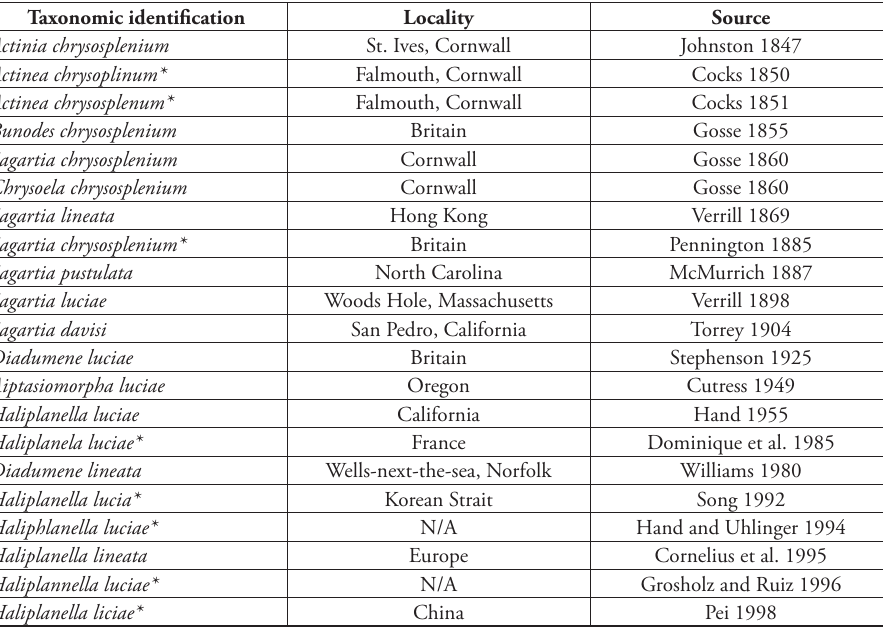
Table 1. Synonyms, misidentifications, and their localities for D. lineata (after Fautin 2015).